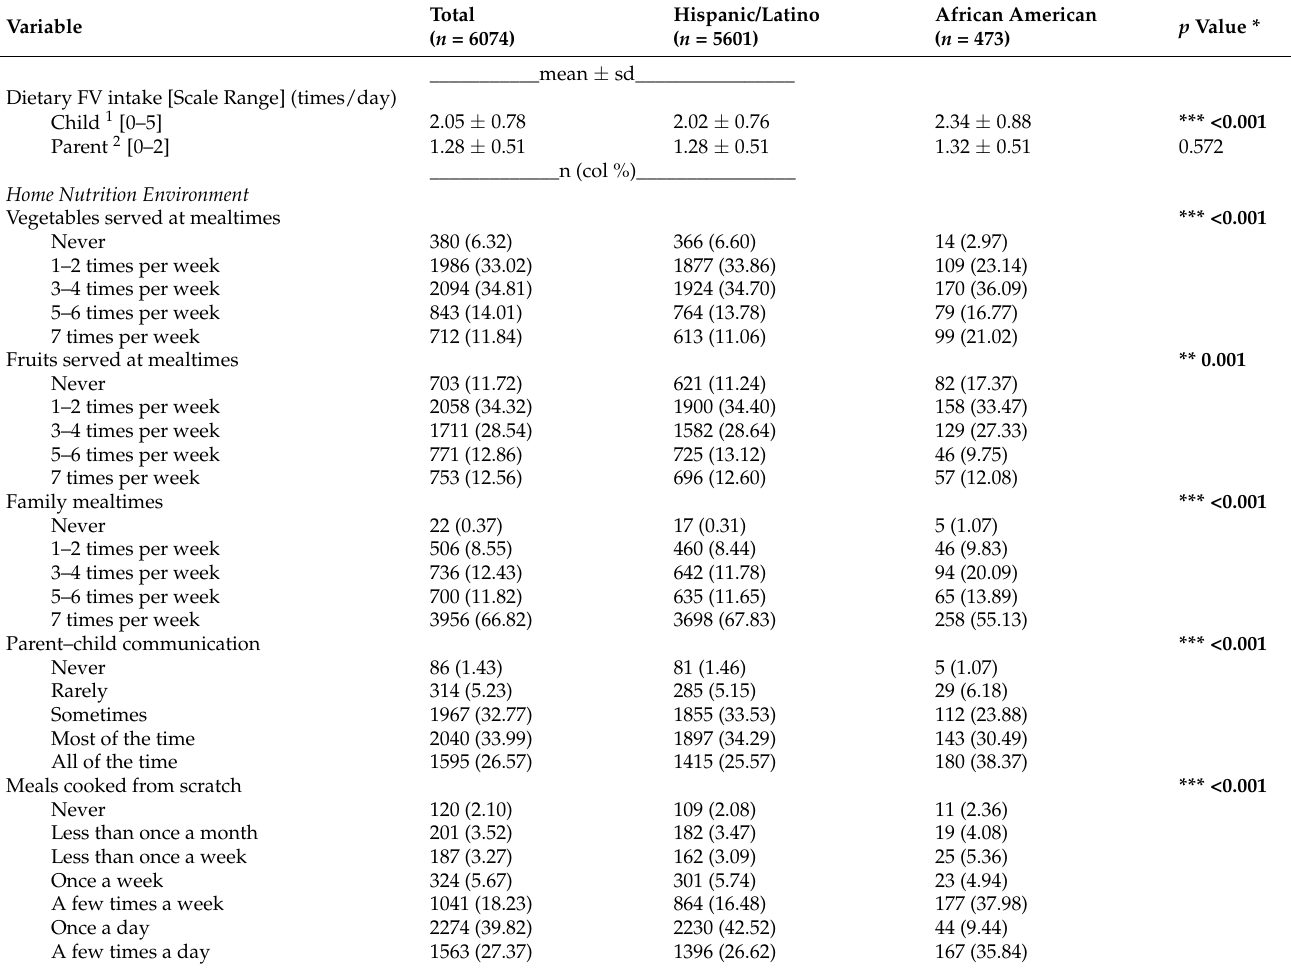
Table 2. Baseline Characteristics of Dietary Fruit and Vegetable (FV) Intake and the Home Nutrition Environment of Brighter Bites Participants ( n = 6074) Stratified by Race/Ethnicity, Fall 2018 Pre-Parent